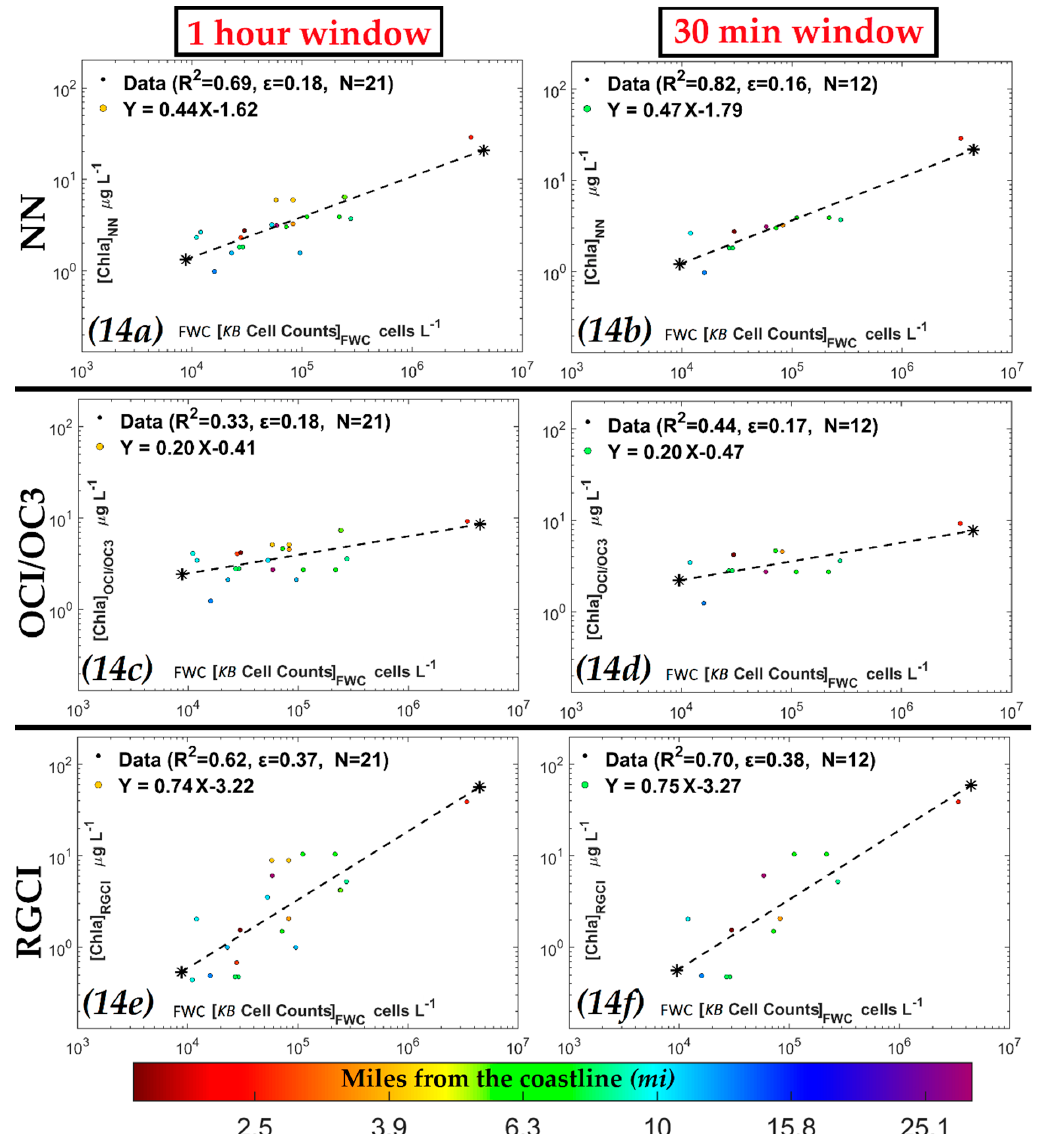
Figure 14. ( a – f ) Retrieved NN equiv. [ Chla ] and OCI/OC3 [ Chla ] and RGCI [Chla] against in situ cell counts for 1 h and 30 min observation time windows. Note that the vertical color bar is indicates distant (mi) from coastline with red being closest to